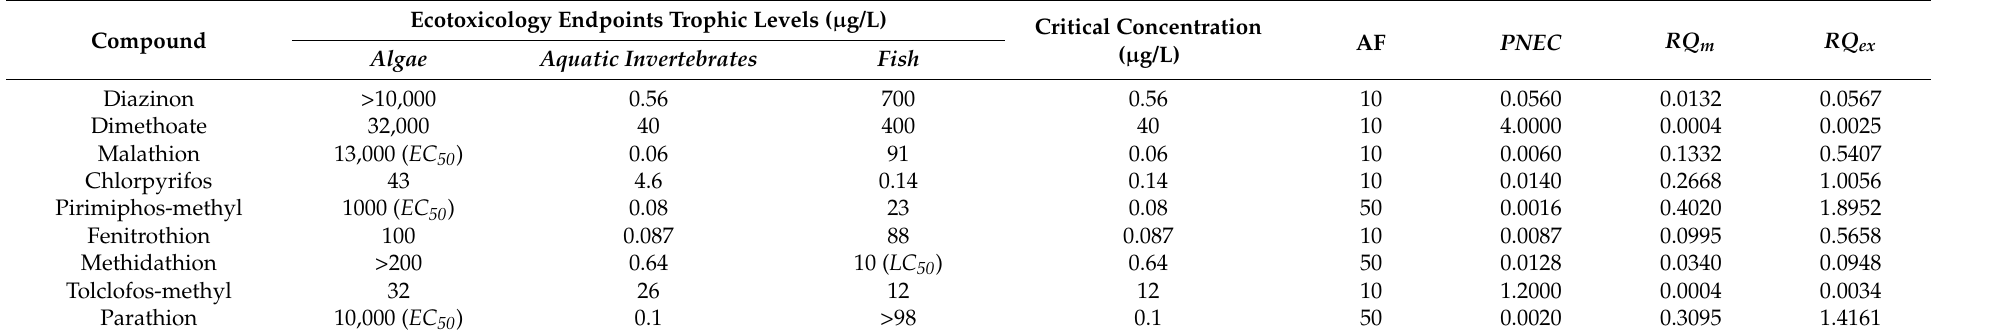
Table 6. Ecotoxicology risk assessment data for the OPPs detected in the Sele River WDP with ecotoxicity endpoints for three trophic levels (algae, aquatic invertebrates, and fish), PNEC values ( µ g/L), and risk quotients ( RQ m , RQ ex